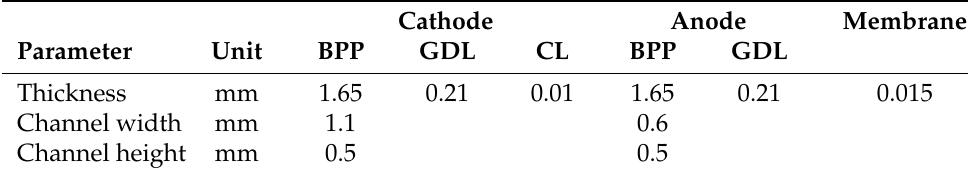
Table 3. Dimensions of fuel cell components. Thicknesses for GDL (at 1MPa compression) and membrane were taken from manufacturers